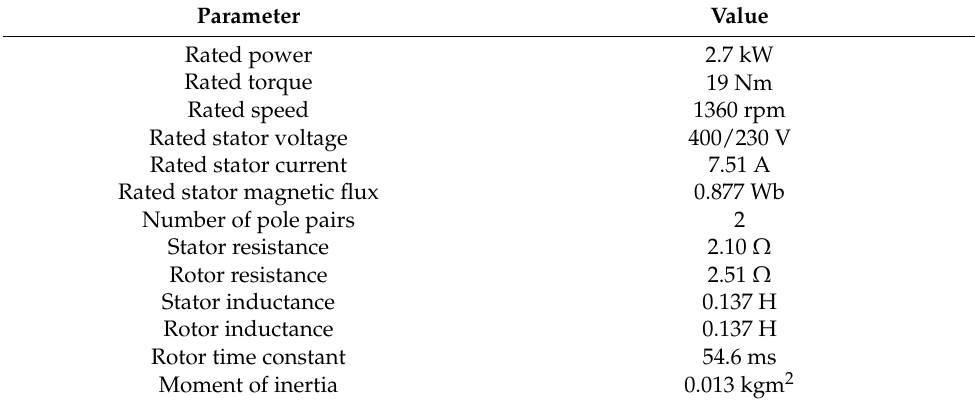
Table 1. Induction motor